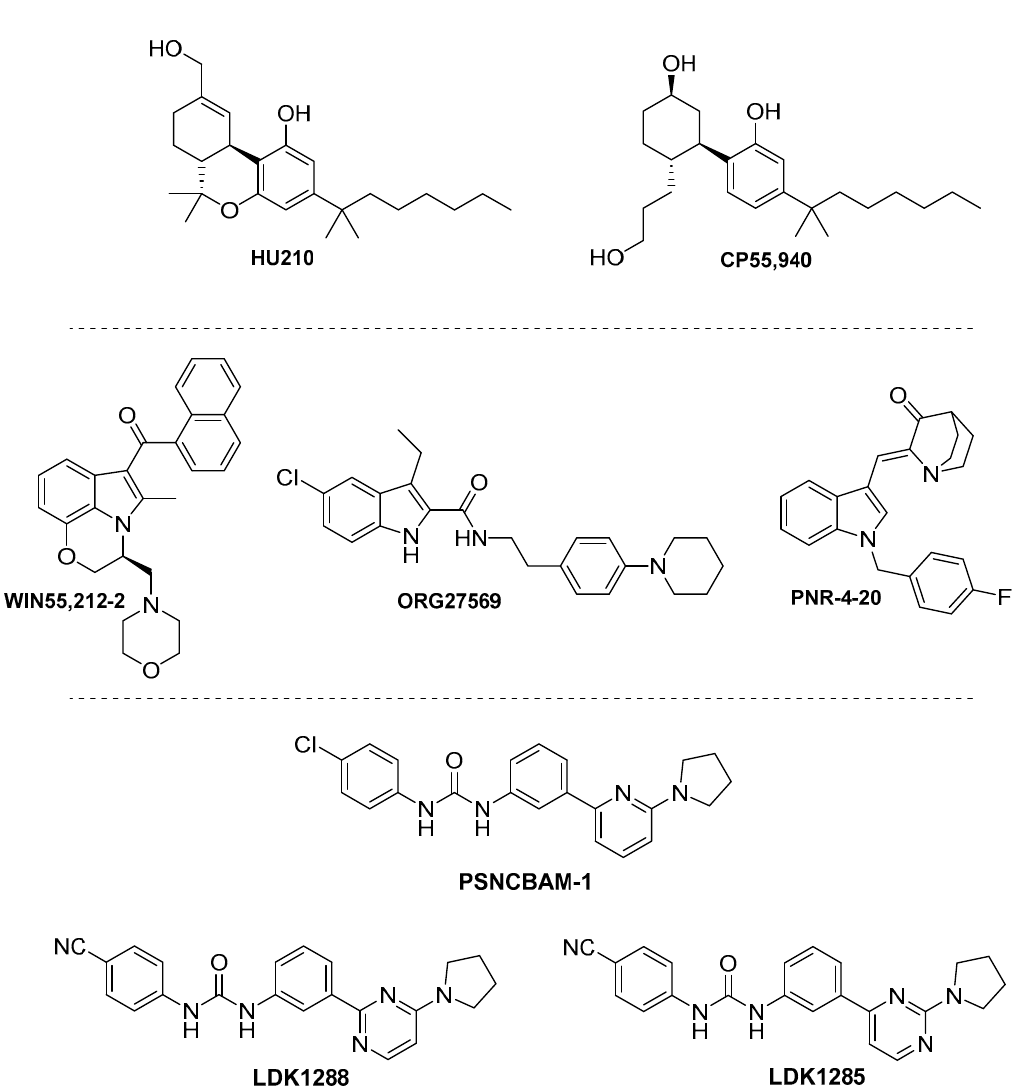
Figure 7. Structures of the phytocannabinoid synthetic ligands HU210 and CP55,940; indole derivatives WIN55,212-2, ORG27569, and PNR-4-20; and biphenylureas PSNCBAM-1, LDJ1288, and LDK1285.